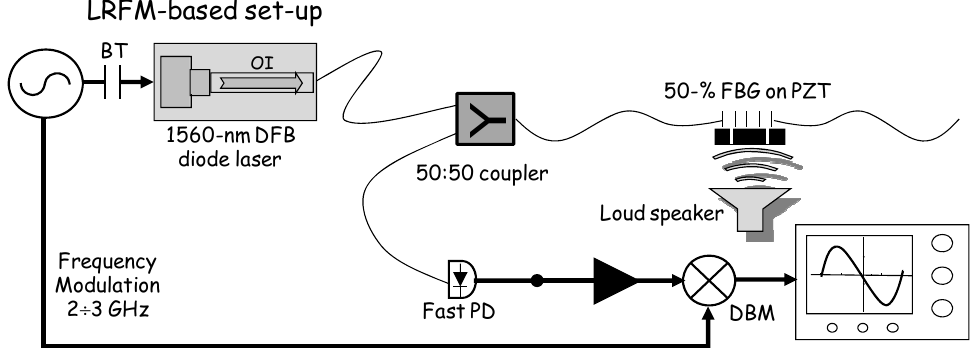
Figure 1. RF-modulation-based FBG interrogation set-up. PD: photodiode; DBM: double-balanced mixer; BT: